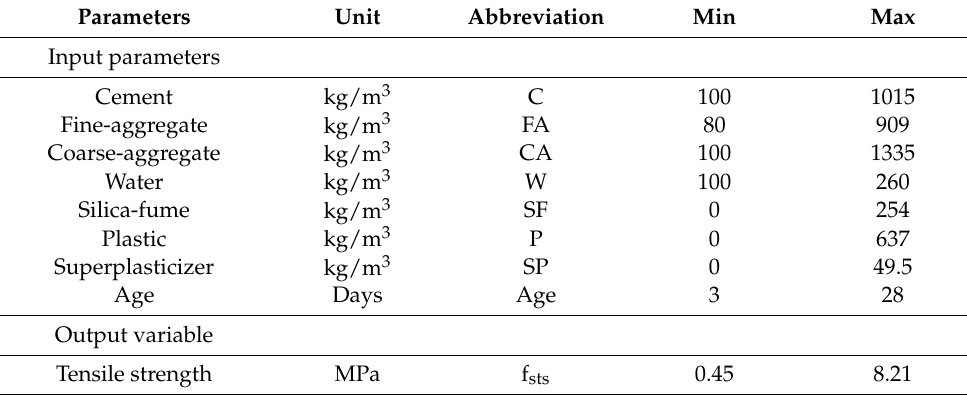
Table 4. The range of input and output variables for developing the split tensile strength model of plastic